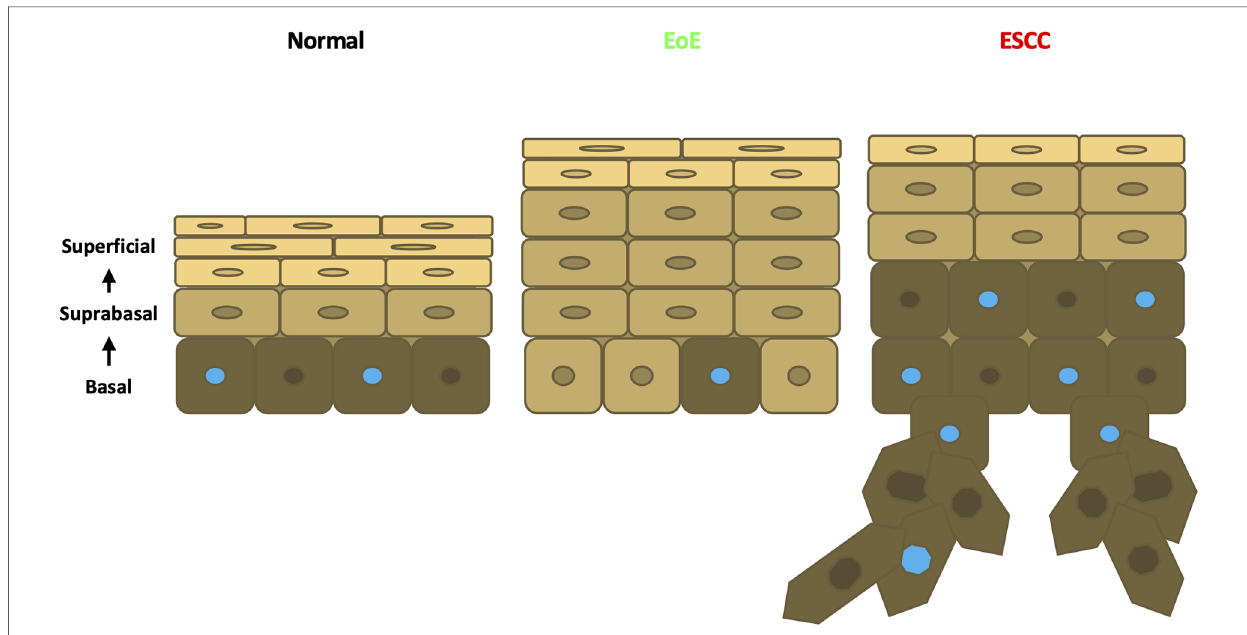
FIGURE 8 Schematic model of esophageal epithelium in normal, EoE, and ESCC conditions. In normal esophageal epithelium, basal cells give rise to overlying suprabasal cells then terminally differentiated super fi cial cells. Proliferative cells are denoted with a blue nucleus. In EoE, an expansion of suprabasal cells is present in the epithelium. In ESCC, an expansion of both suprabasal and basal cells is present in the epithelium and encroaches into the underlying